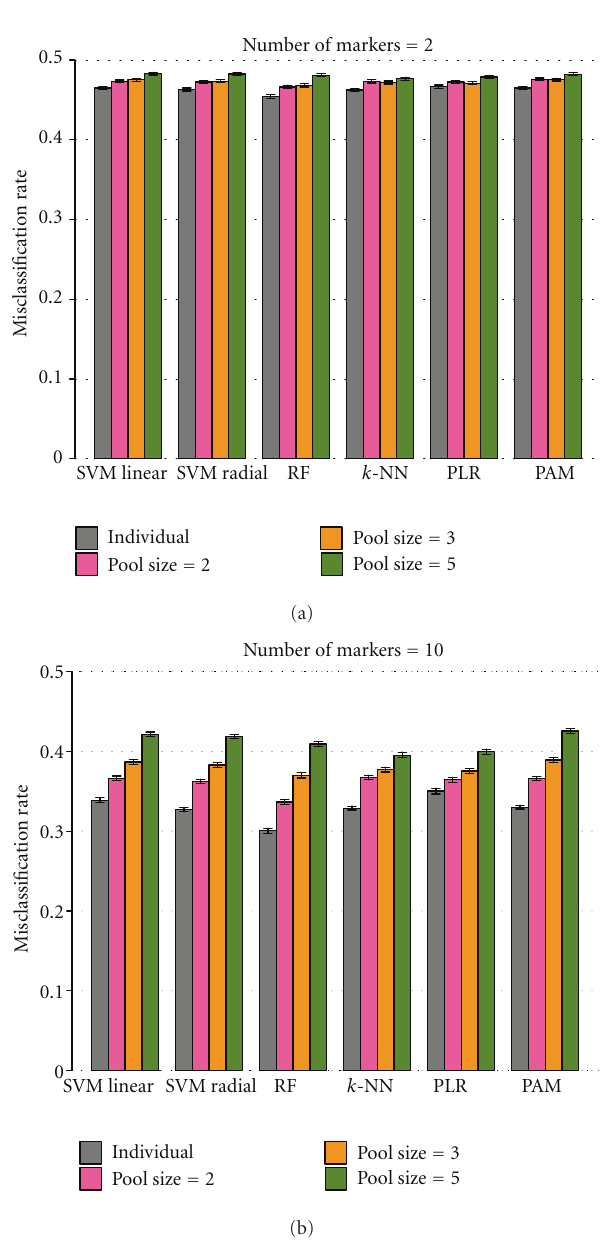
Figure 4: Performance of classifiers based on the animal scenario. Performance of classifiers for datasets of individual samples and pool sizes of 2, 3, and 5 are compared. Misclassification rates rise with larger pool sizes as the human scenario. (a) and (b) show the comparison when numbers of markers are 2 and 10, respectively. The height of bars indicates 95% confidence interval from 300 replications.